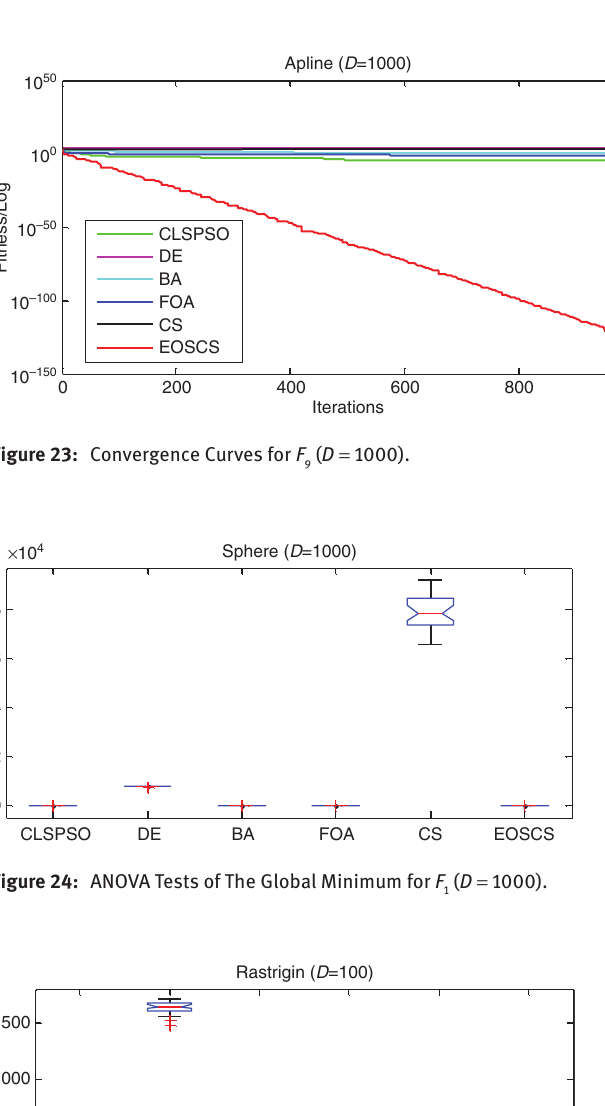
Figure 25: ANOVA Tests of The Global Minimum for F